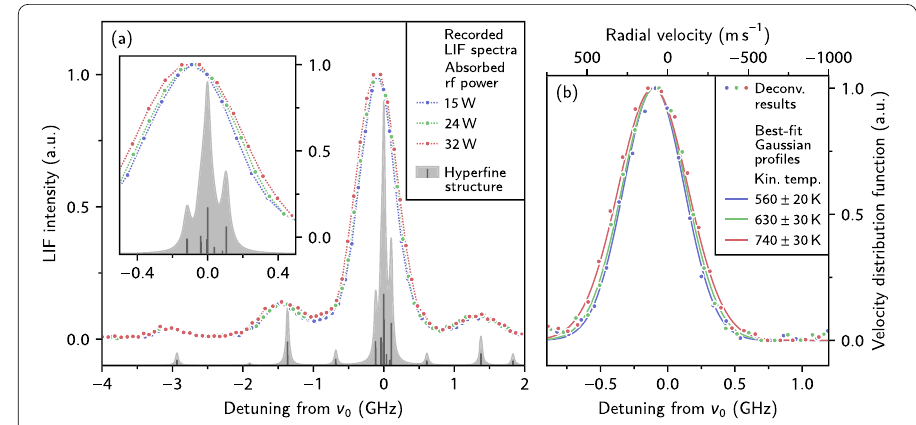
Figure 11 ( a ) Xenon LIF spectra of the transition at 834.7 nm measured in the center of the ion source discharge chamber for three different operation conditions (normalization to maximum LIF intensity; dotted lines are guides to the eyes). The computed naturally broadened hyperfine structure lineshape has been drawn with a vertical offset for clarity. The inset shows the line center with a stretched frequency detuning axis. ( b ) Doppler lineshapes (projected radial velocity distribution functions, respectively) extracted from the LIF spectra (circle markers) and best-fit Gaussian profiles (solid lines) depending on the respective kinetic temperature of the xenon